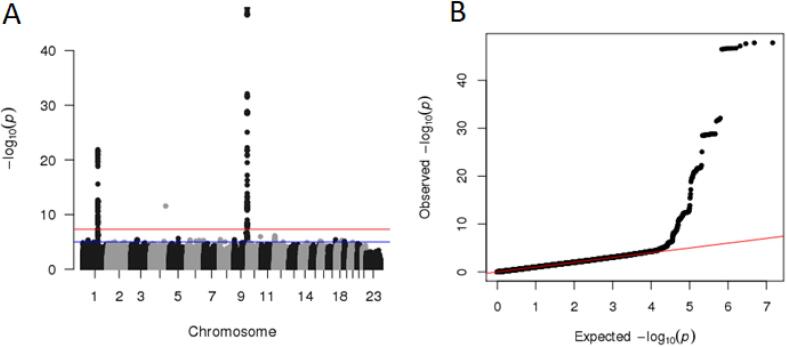
A) Manhattan plot and B) quantile–quantile plot of Interleukin-6 Meta-analysis of ALSPAC and SardiNIA cohorts.